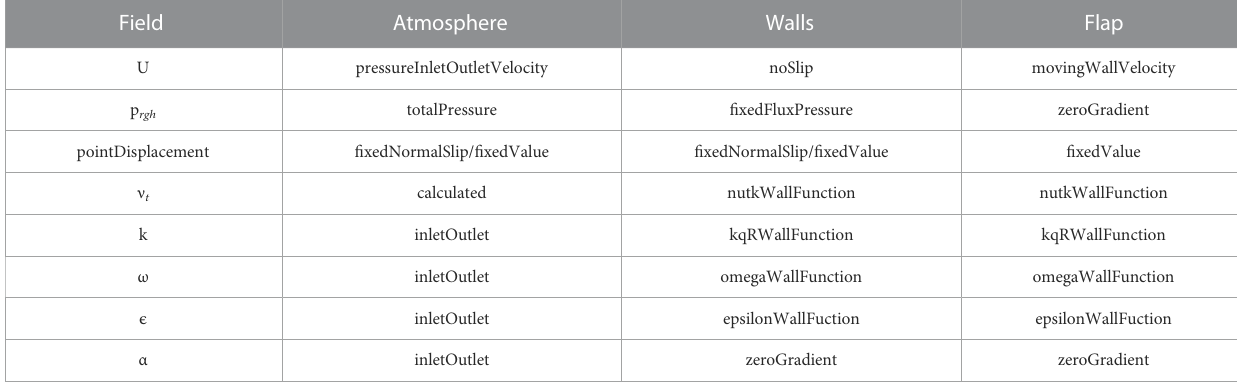
TABLE 2 Model boundary conditions for all fi eld